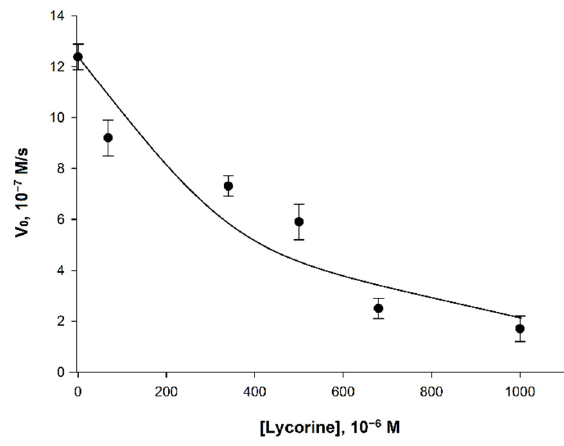
Figure 5. Dependence of the initial velocity (V 0 ) on the concentration of lycorine. Measurements were performed in 25 mM phosphate buffer at pH 8.8 using a combination of 120 μ M phenazine methosulfate and 120 μ M dichlorophenolindophenol. The concentrations of AtGALDH and L -galactone-1,4-lactone were 6 × 10 − 9 M and 1 mM, respectively. Values are presented as the mean ± SD of three experiments.